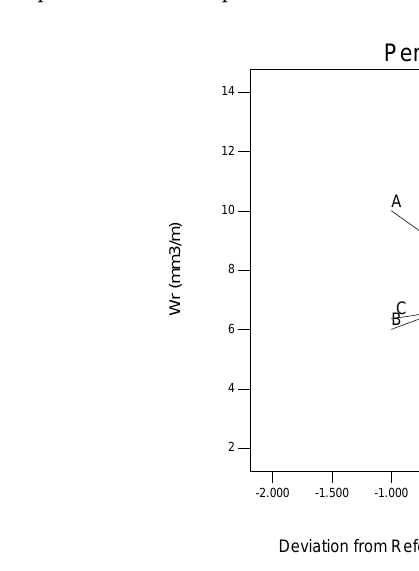
Figure 2. Perturbation plot of the effect of Fly ash content, sliding speed and applied load on wear rate of AA6063-FA composites.